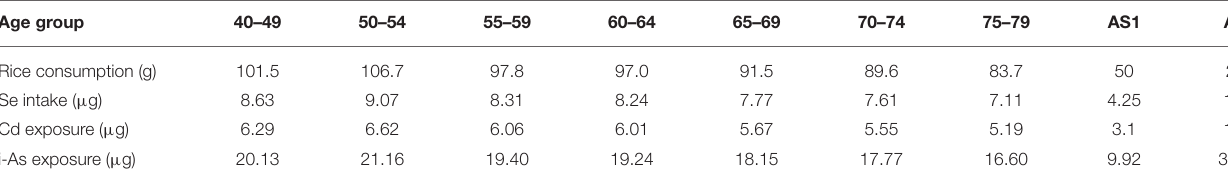
TABLE 3 | Exposure assessment of Se and Cd for baseline and alternative scenarios.